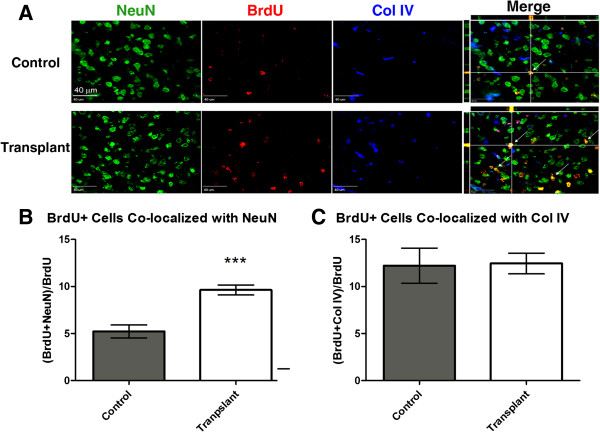
Transplantation of hES cell-derived neural precursors increases BrdU co-localization with NeuN. (A) Representative images of staining for NeuN (green), BrdU (red), and Col IV (blue) in the penumbra region of a medium control and a cell transplant animal. White arrows indicate co-localization of NeuN and BrdU. Scale bars = 40 μm. (B) A significantly higher percentage of BrdU-positive cells in the transplant animals co-localized with NeuN as compared with control animals, potentially indicating a higher degree of neurogenesis. ***P <0.001, n = 6 (control) and 8 (transplant). (C) No significant difference was observed in the percentage of BrdU-positive cells co-localized with Col IV, indicating no difference in angiogenesis. n = 6 (control) and 7 (transplant).